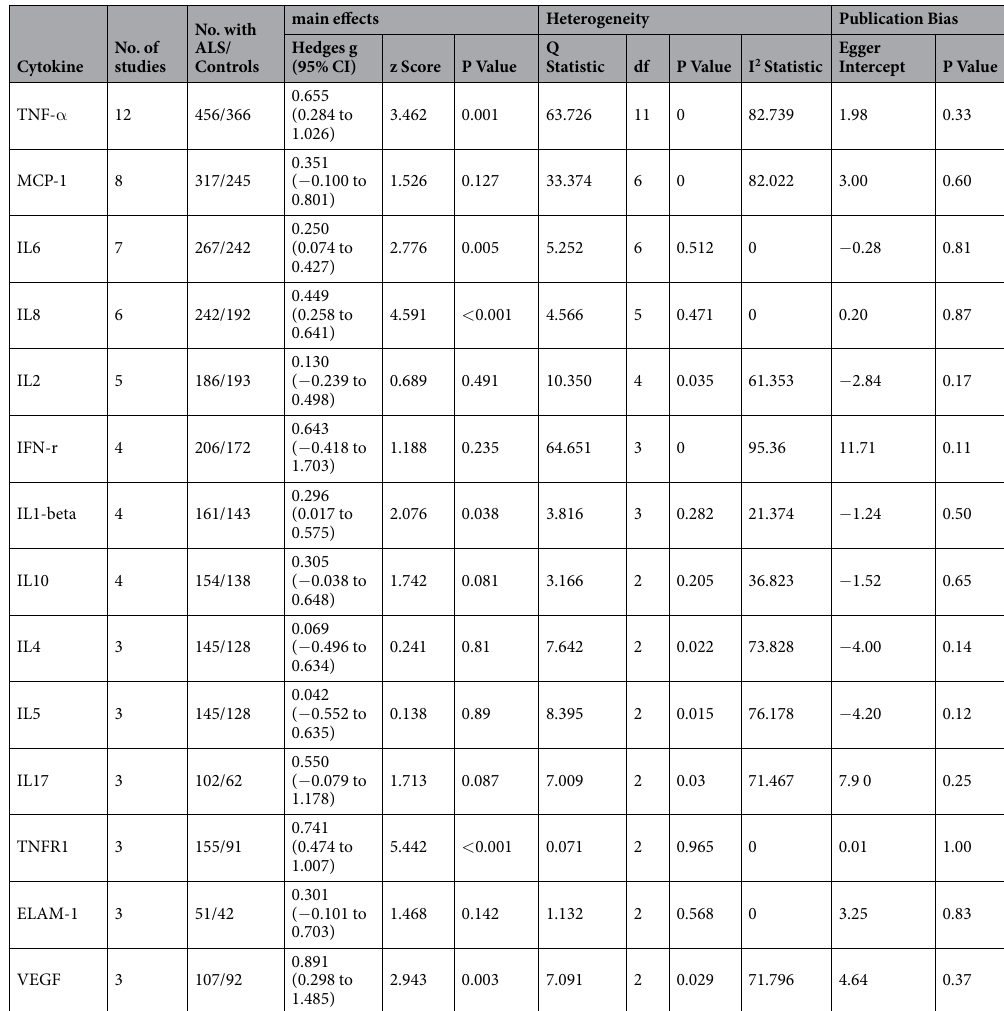
Table 1. Summary of comparative outcomes for peripheral blood cytokine measurements. N, sample size; CI, confidence interval; ALS, amyotrophic lateral sclerosis; TNF, tumor necrosis factor- α ; TNFR1, TNF receptor 1; IFN, interferon; IL, interleukin; ELAM, endothelial leukocyte adhesion molecule; MCP-1, Monocyte chemotactic protein-1; VEGF, vascular endothelial growth factor; df, degree of freedom; Q, Cochran’s Q test; z (test of null hypothesis); p (statistical significance); I 2 (heterogeneity